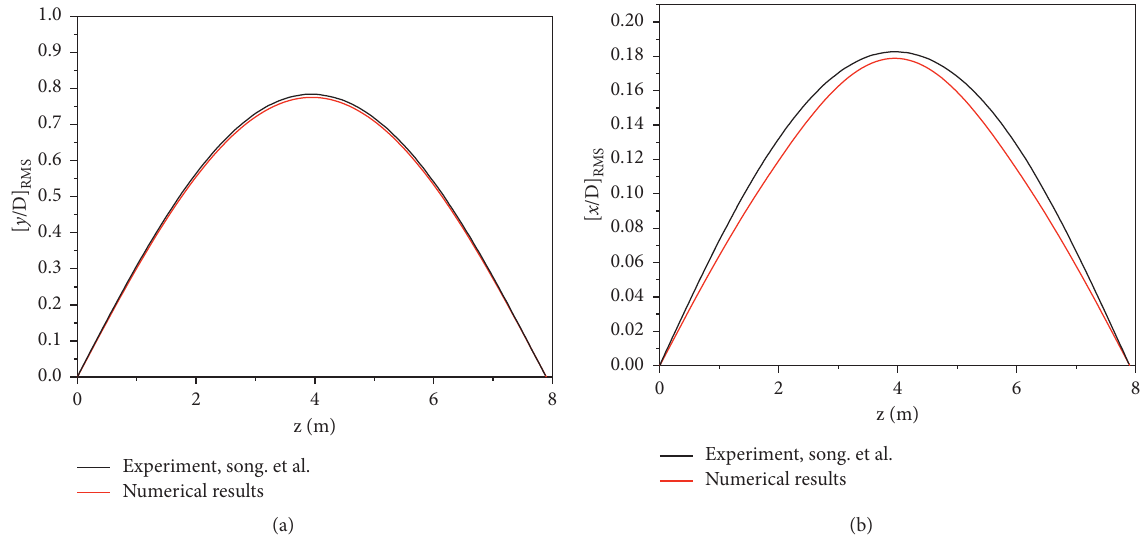
Figure 3: Verification diagram of RMS distribution of riser displacement with reduced velocity of 5.87: (a) CF; (b) IL.